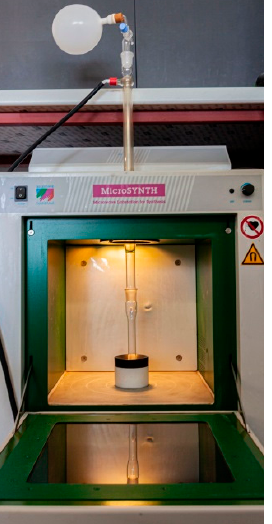
Figure 3. Experimental apparatus for 2-aryl-2,3-dihydroquinolin-4(1 H )-ones microwave-assisted Figure3. Experimentalapparatusfor2-aryl-2,3-dihydroquinolin-4(1 H synthesis.